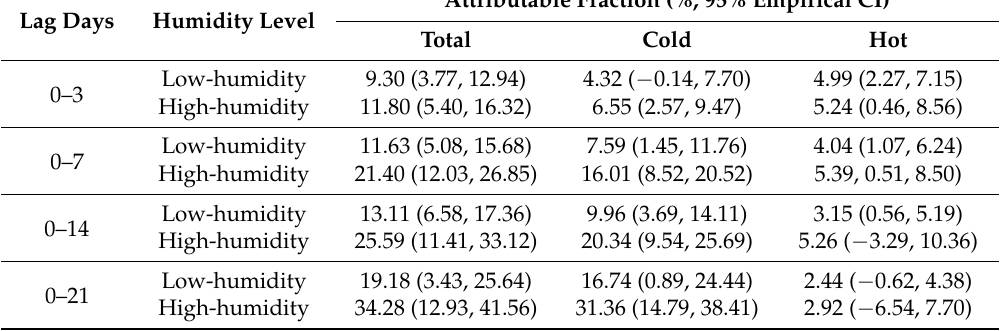
Table 3. The pooled attributable fractions of cold and hot effects on CVD mortality over multiple lag days at different levels of humidity.